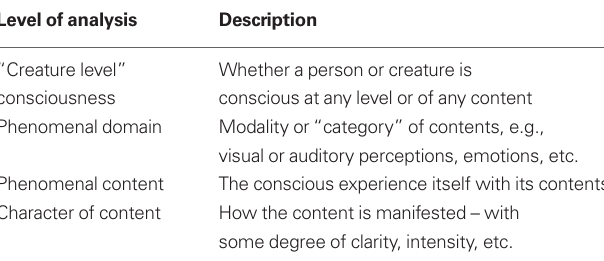
Table 2 | Levels of analysis in the relation between conscious and neural events. The number of levels and their labeling are